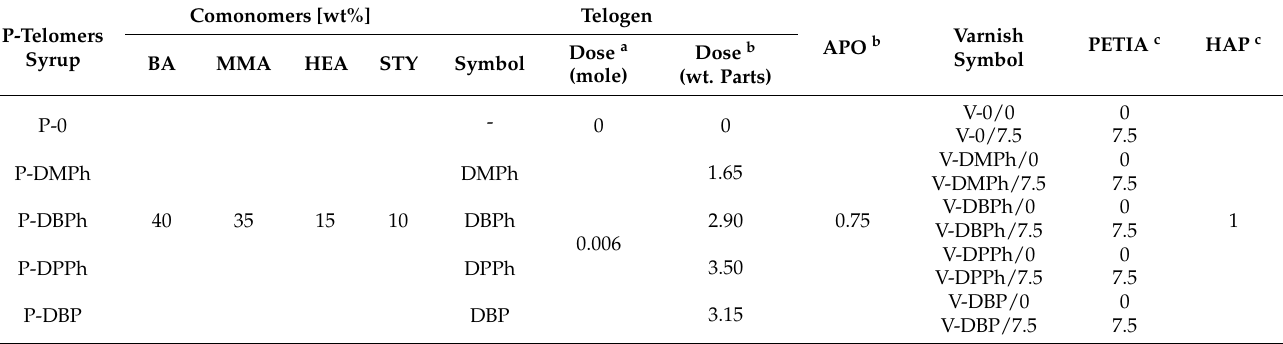
Table 1. Composition of P-telomers syrups and UV-photocurable